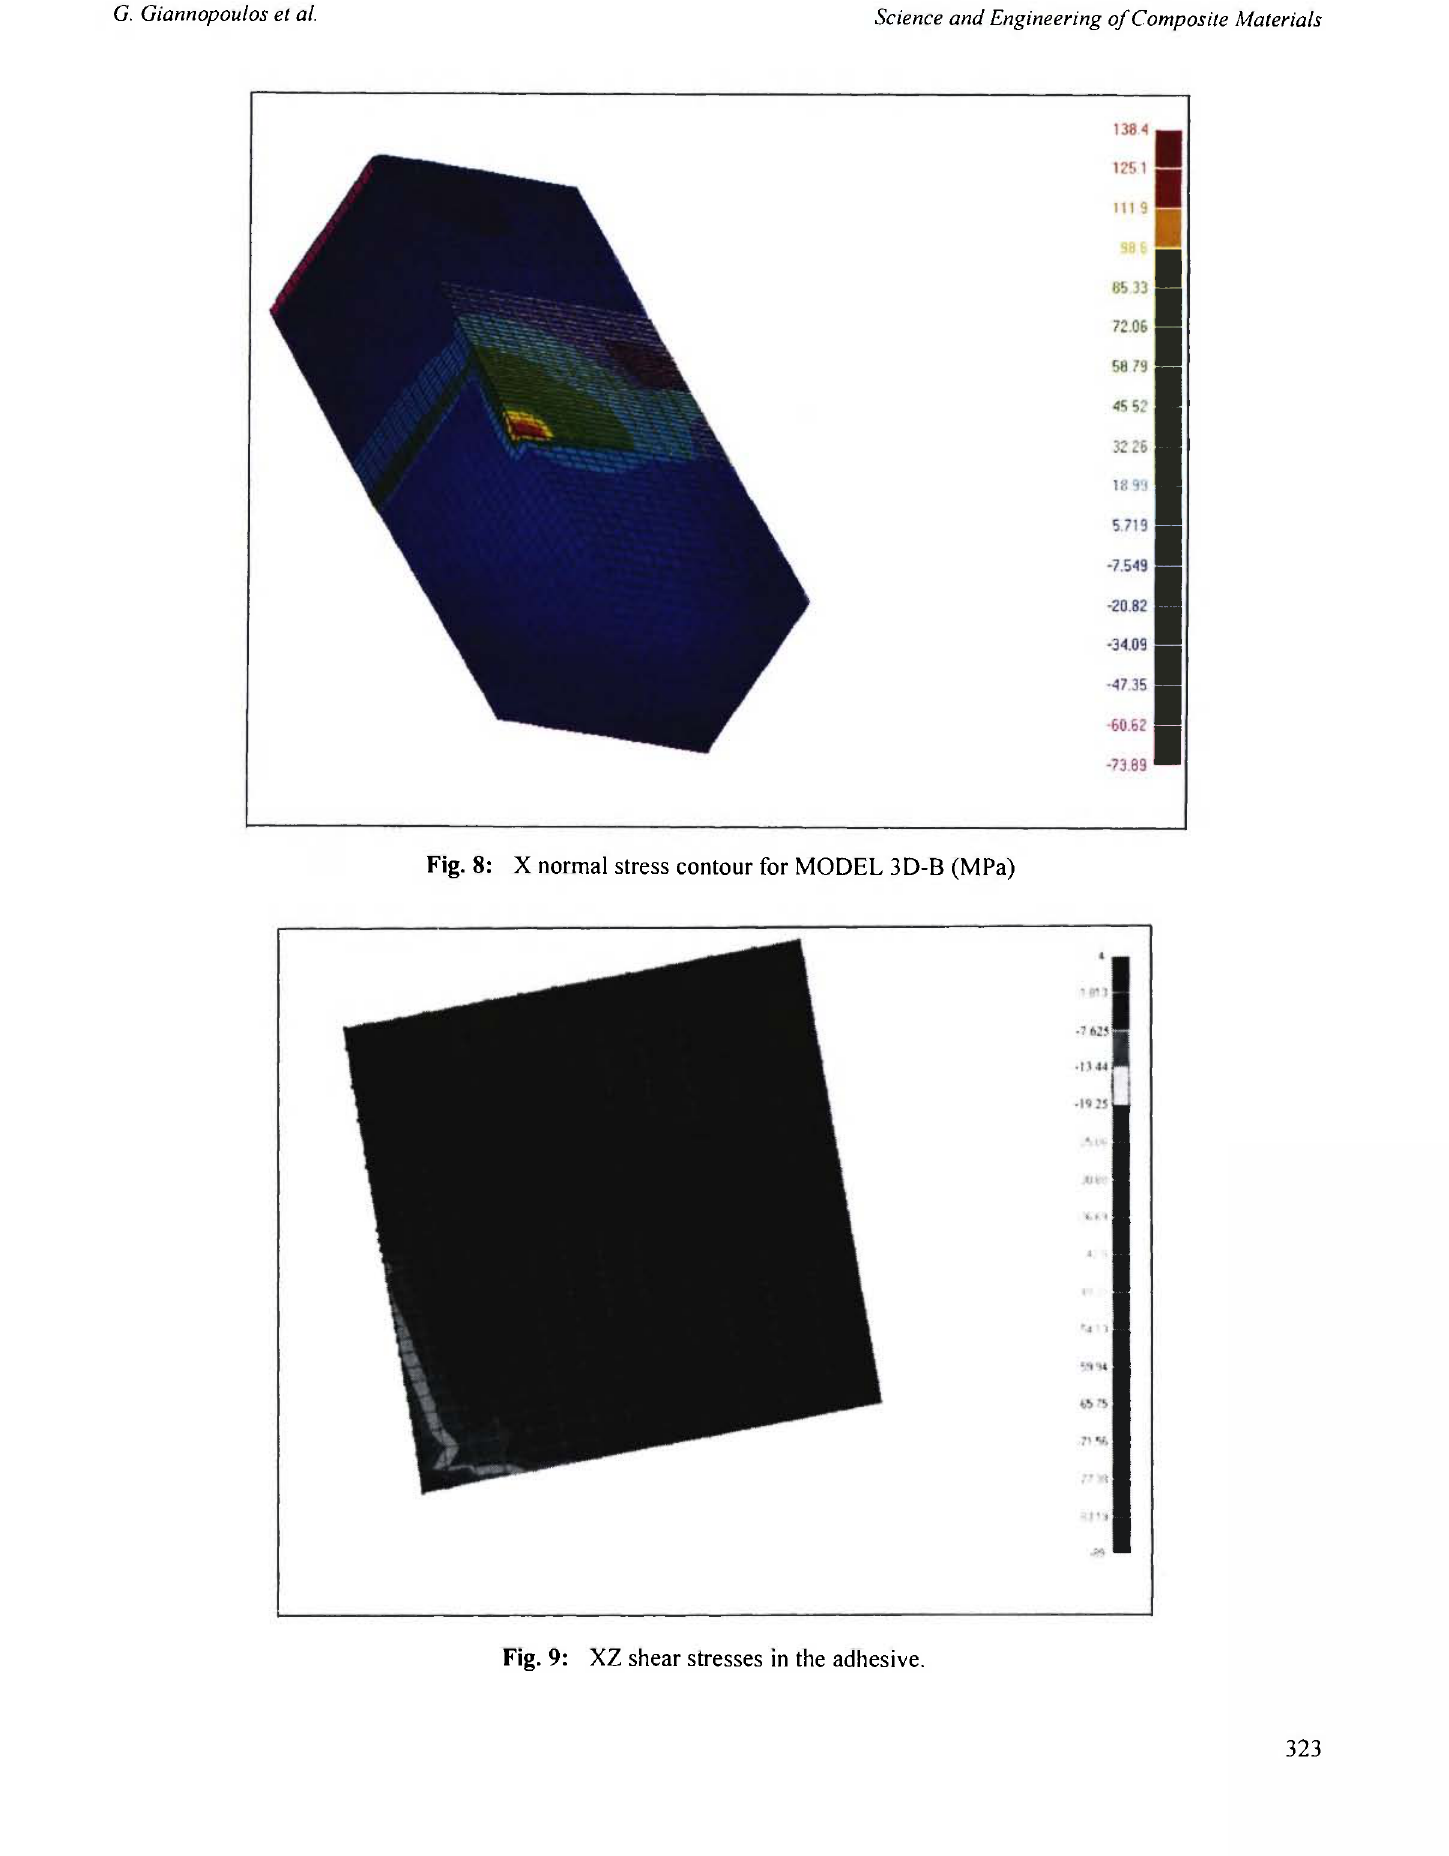
Fig. 8: X normal stress contour for MODEL 3D-B (MPa)